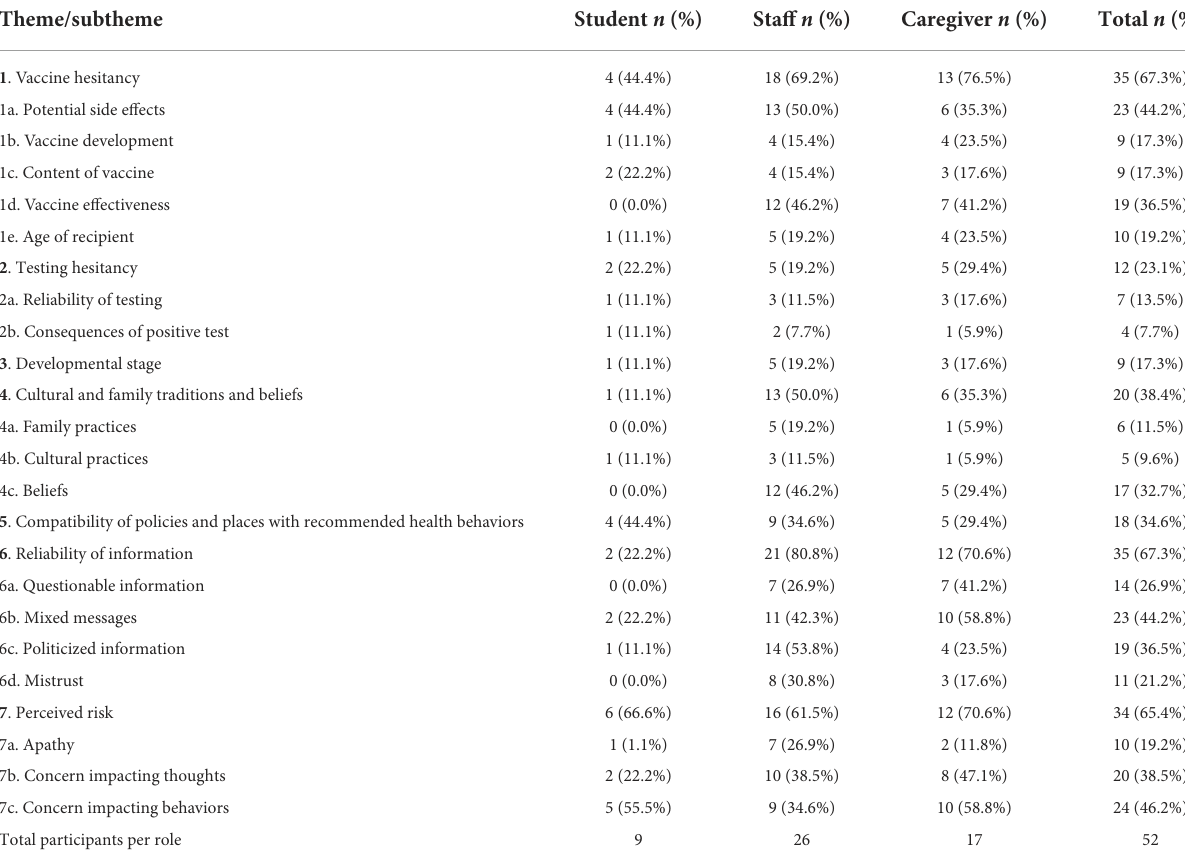
TABLE 3 Frequency of Individuals endorsing themes by